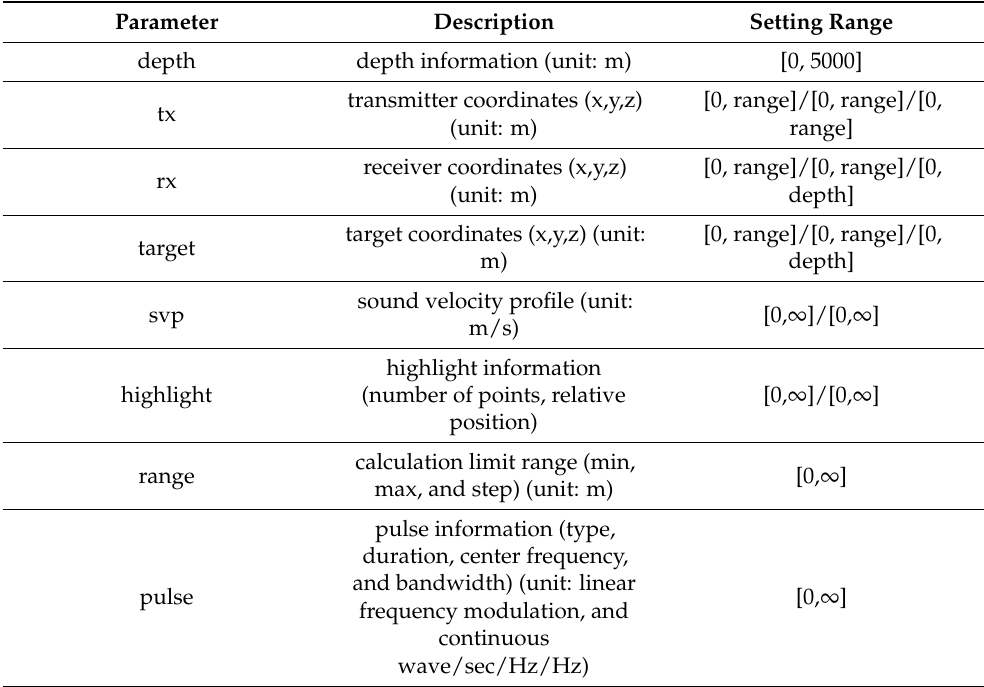
Table 1. Input parameters of the highlight-based active sonar signal